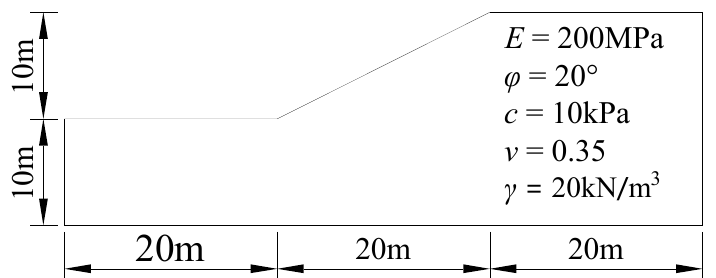
Figure 3. Dimension of the model in Example 1.